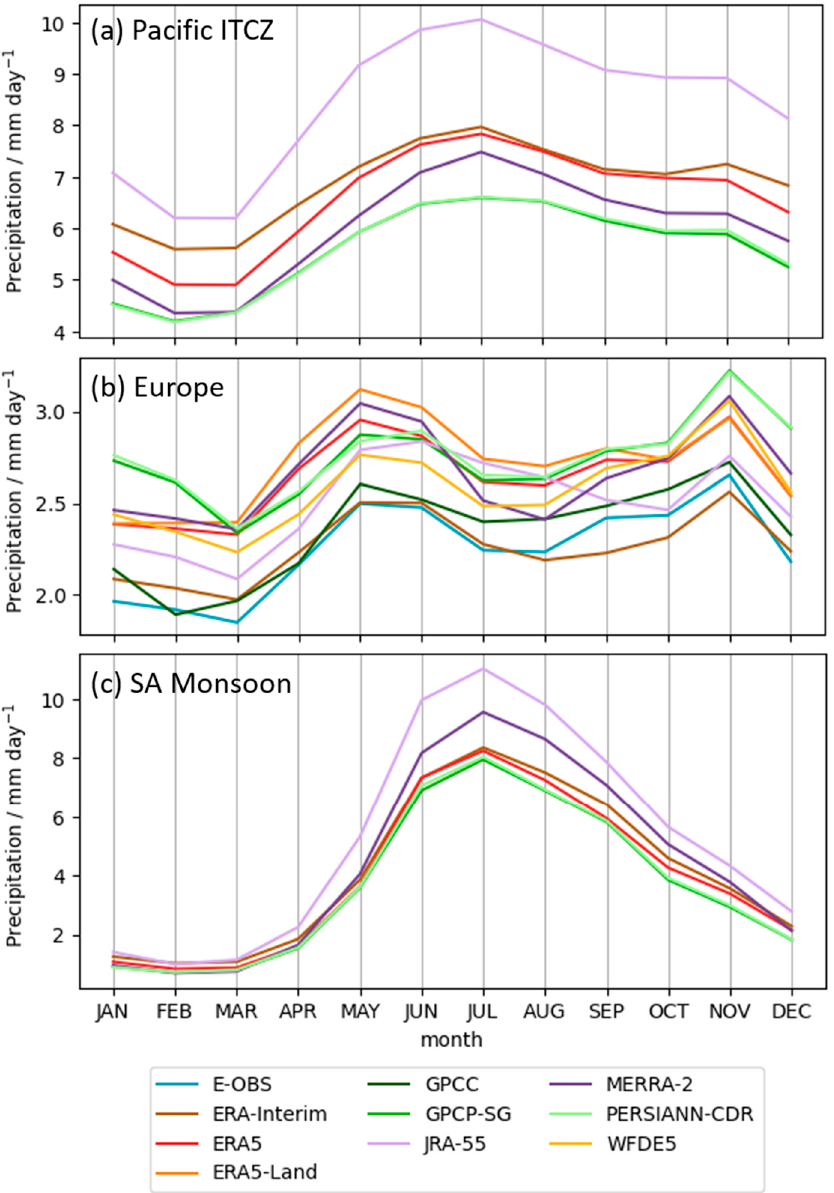
Figure 11. Annual cycle of precipitation rates for ( a ) the Pacific ITCZ, ( b ) Central Europe (including ERA5-Land, GPCC and WFDE5 data), and ( c ) the SA Monsoon region averaged over the period 1983–2016.